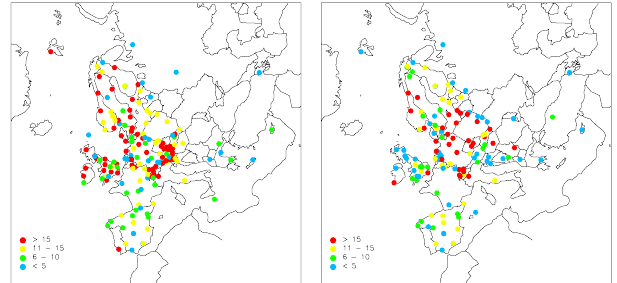
Fig. 9. Number of years with EMEP monitoring data during 1990– 2009 for ozone (left) and NO 2 (right).